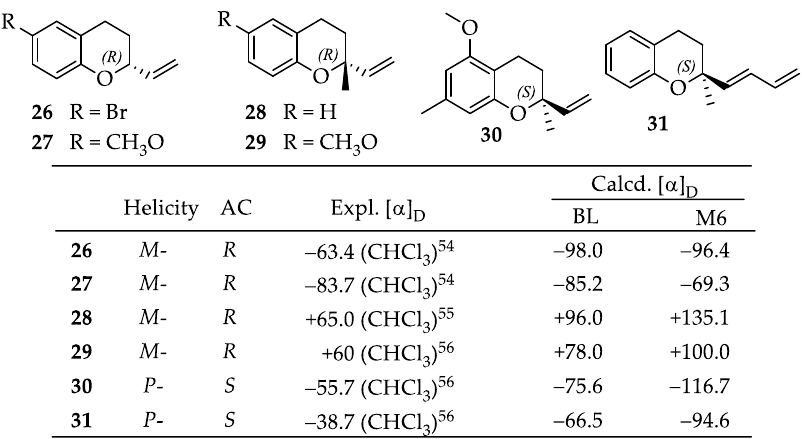
Figure 4. Experimental and predicted SOR values for compounds 26 – 31 . Experimental SOR data were collected from references [54 – 56].